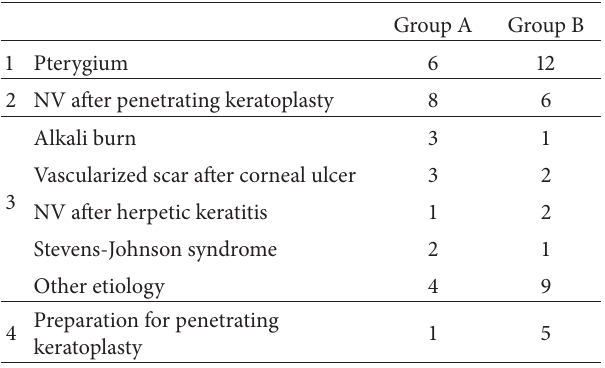
Table 1: Distribution of patients into groups A and B and subgroups 1, 2, 3, and